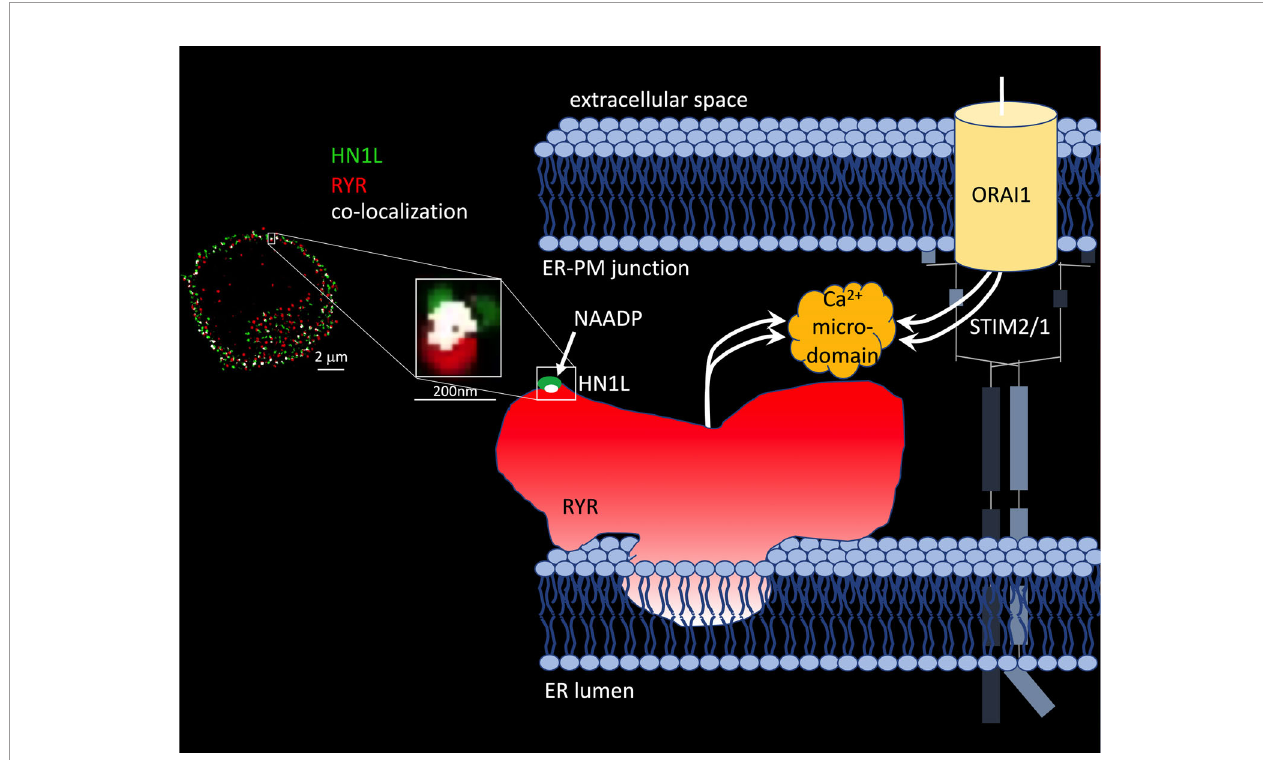
FIGURE 1 | HN1L/JPT2 co-localization with ryanodine receptors and scheme of Ca 2+ microdomain formation by ryanodine receptors and ORAI1 channels in ER-PM junctions of T cells. Left: Co-localization of HN1L/JPT2 with RYR shown by super-resolution microscopy in a single Jurkat T cell [image taken from Figure 6 of (45)]. From (52). Reprinted with permission from AAAS. Right: scheme of Ca 2+ microdomain formation by RYRs and ORAI1 channels in ER-PM junctions of T cells. Abbreviations used: STIM1/2, stromal interaction molecule 1 and/or